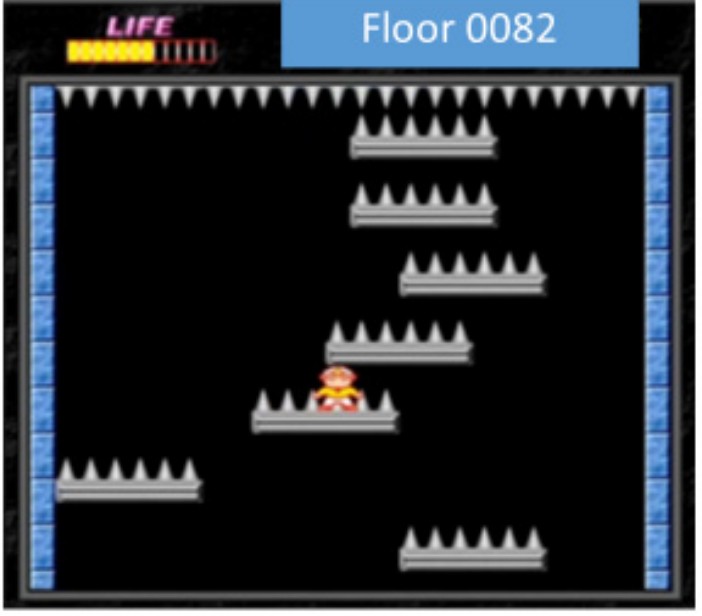
Figure 20. 80-layer schematic. Figure 20. 80-layer